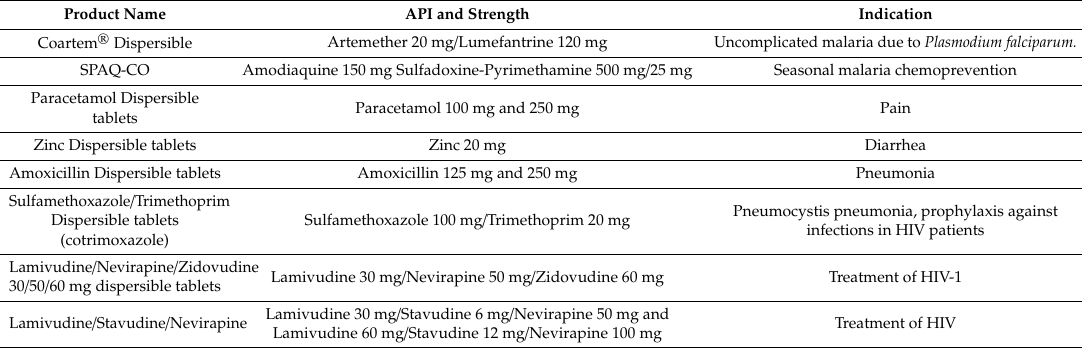
Table 3. Examples of Dispersible Products for Low to Middle-Income